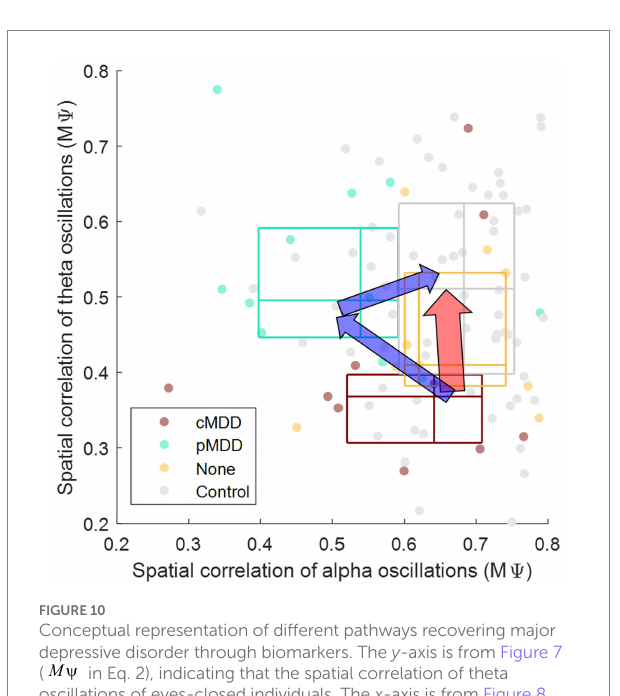
FIGURE 10 Conceptual representation of different pathways recovering major depressive disorder through biomarkers. The y -axis is from Figure 7 ( M ψ in Eq. 2), indicating that the spatial correlation of theta oscillations of eyes-closed individuals. The x -axis is from Figure 8 ( M ψ in Eq. 2), indicating that the spatial correlation of alpha oscillations of eyes-open individuals. The boundary lines of each box indicate 25 and 75% of data, respectively. The cross line of each box indicates 50% of data. The red arrow represents the recovery without residual depressive symptoms. The blue arrow represents the recovery with residual depressive